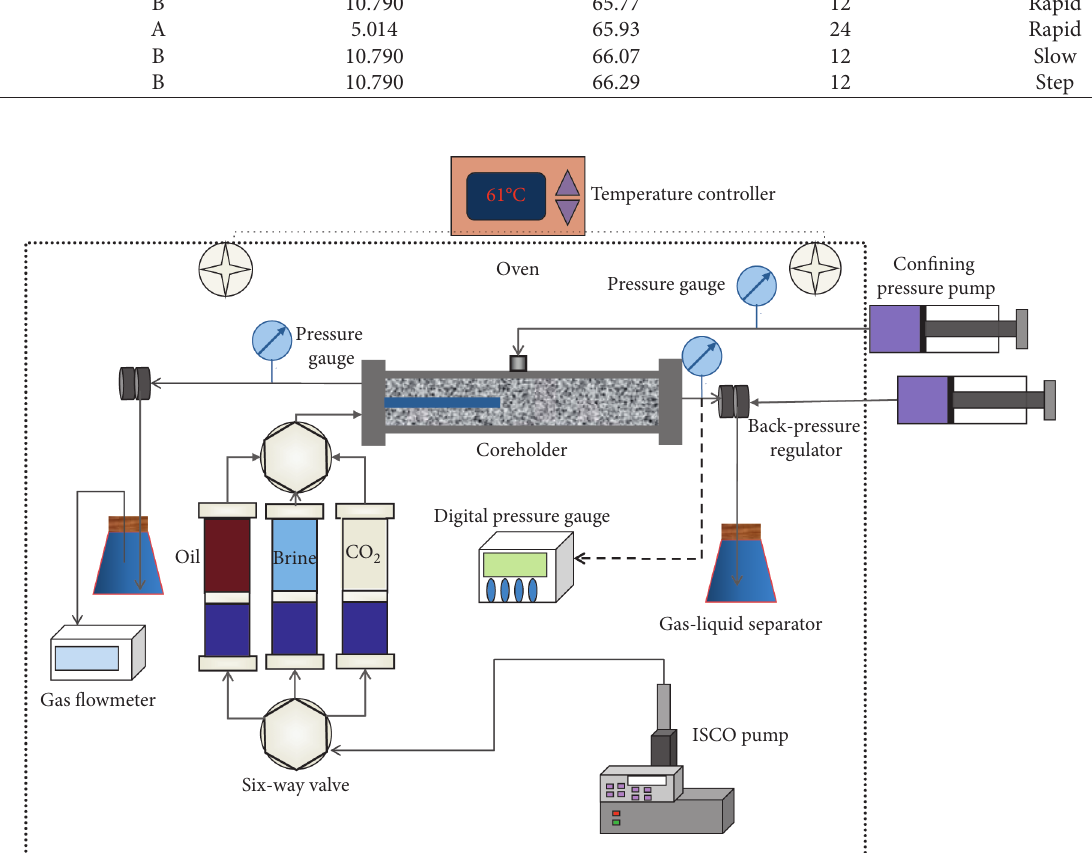
Figure 5: Schematic diagram of the experimental setup used for CO